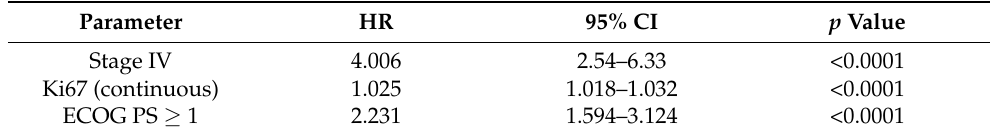
Table 2. Multivariate